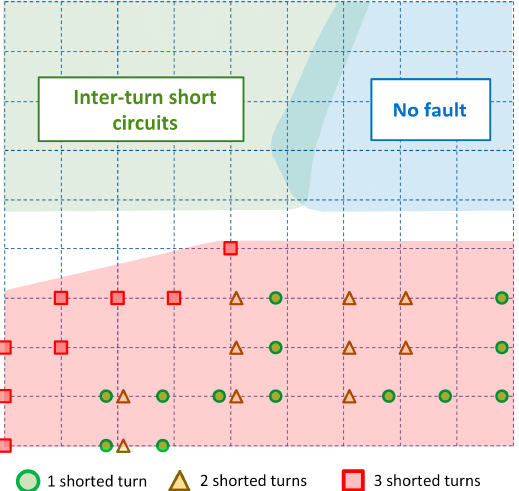
Figure 8. Experimental verification of the SOM-based fault detector of the PMSM motor: simultane- ous fault of the PMSM stator and rotor — SOM response for testing